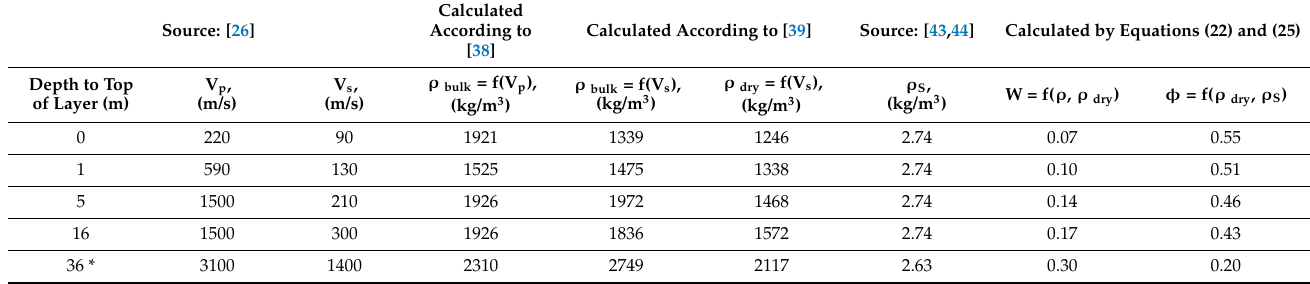
Table 2. Geotechnical parameters (initial and calculated) at the KSRH10 clayey site of the Kik-net